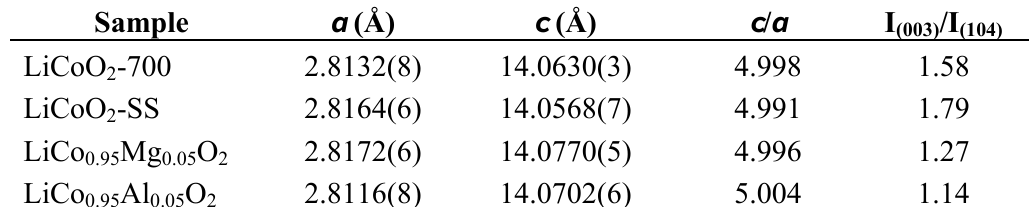
Lattice parameters, c/a ratio and I related